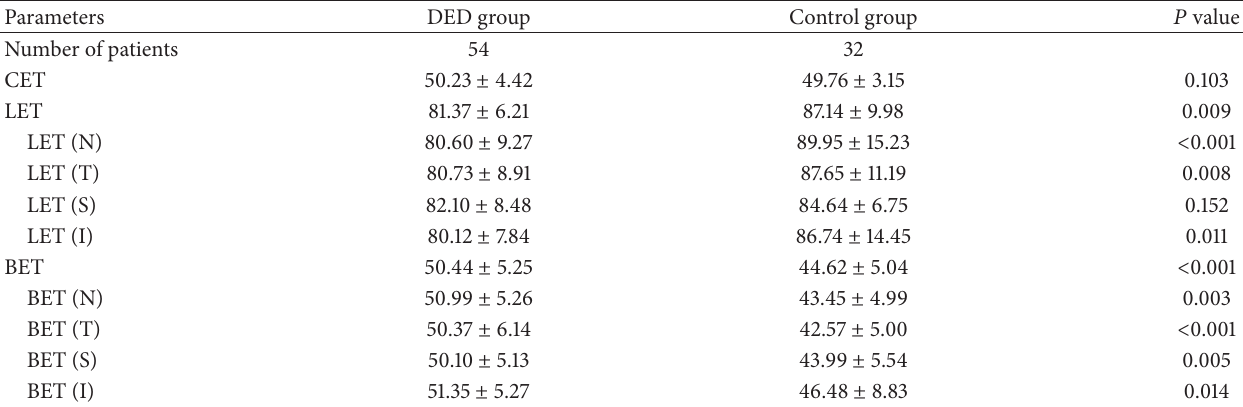
Table 2: Comparison of ocular surface epithelium thickness ( 𝜇 m) between DED and control groups. Parameters